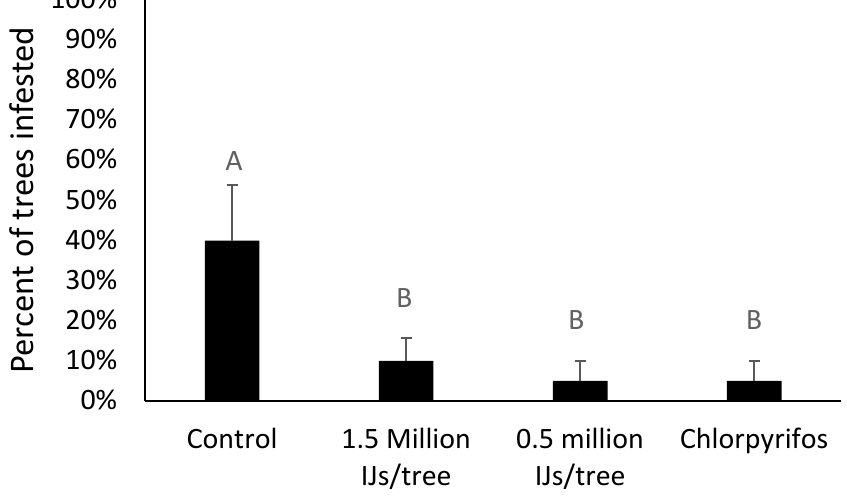
Figure 3. Percentage of peach trees infested with peachtree borers in 2020. Control = no nematodes applied, IJs = infective juveniles. The application was made in a conventional peach orchard in fall 2019 with a reapplication and assessment in spring 2020. Different letters above bars indicate significant differences ( p < 0.05).